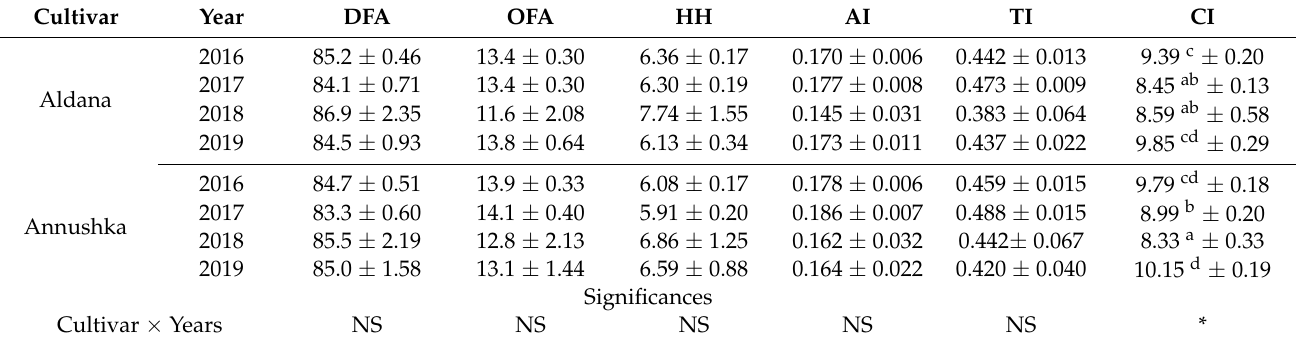
Table 6. The DFA, OFA, HH, AI, TI and CI indices of lipid quality in G. max seed; mean values for interaction cultivar ×